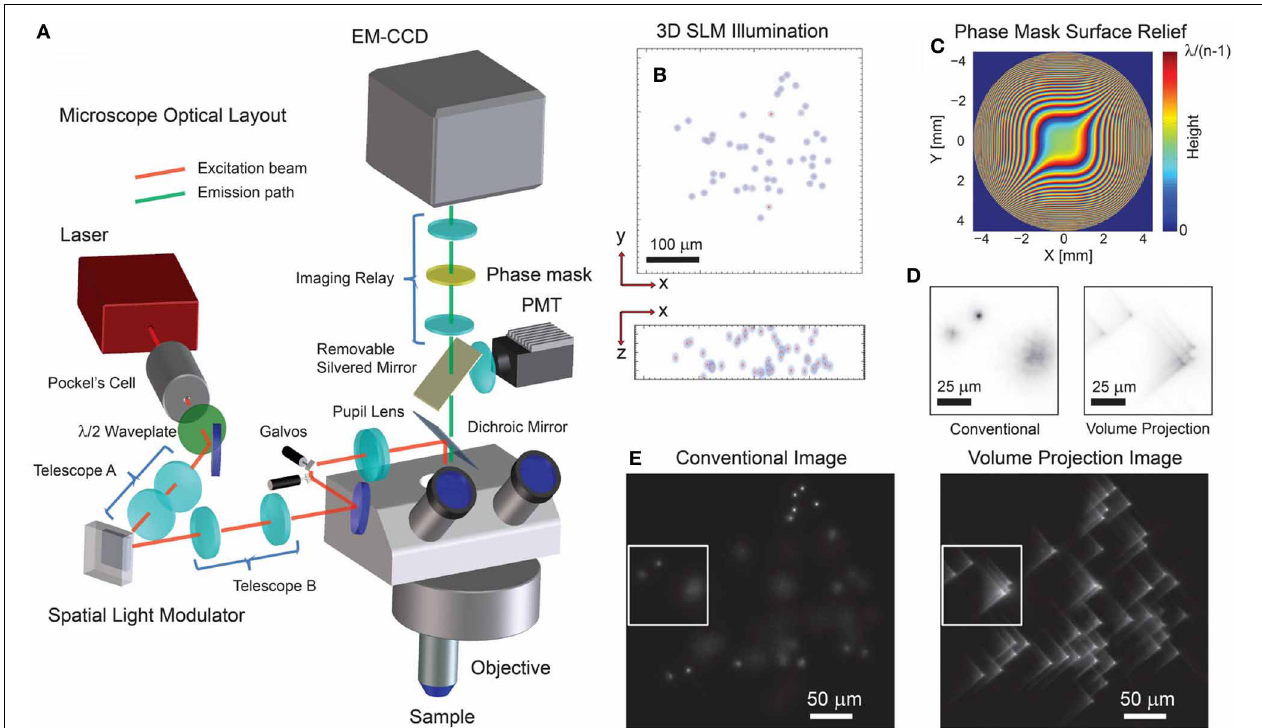
FIGURE 1 | Optical layout and characteristics of 3D projection-based imaging. (A) The optical configuration comprises an illumination path which incorporates a SLM for 3D structured illumination and a modified imaging path using a phase mask (PM) to suppress the imaging effect of defocus. (B) An example 3D illumination pattern using a 20x/0.5NA objective. (C) Ideal surface profile modulation of the phase mask. (D) Experimental imaging